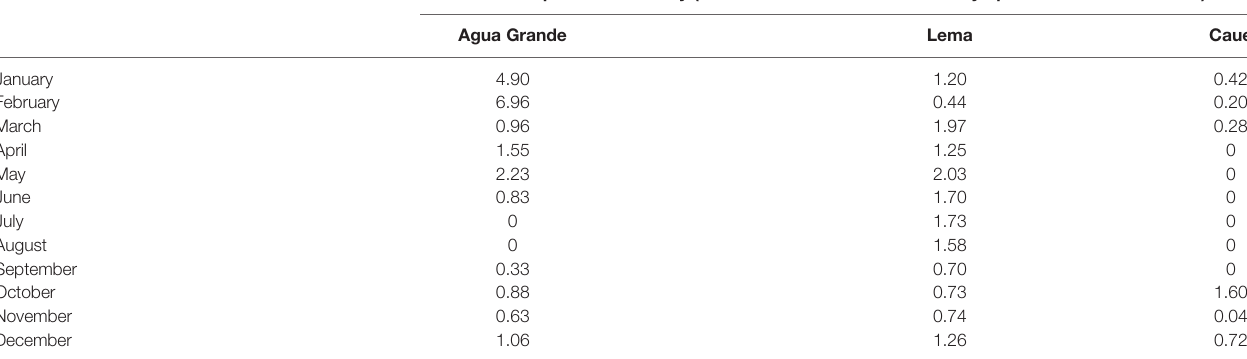
TABLE 3 | Larva mosquito larva density survey in the study sites in 2018.